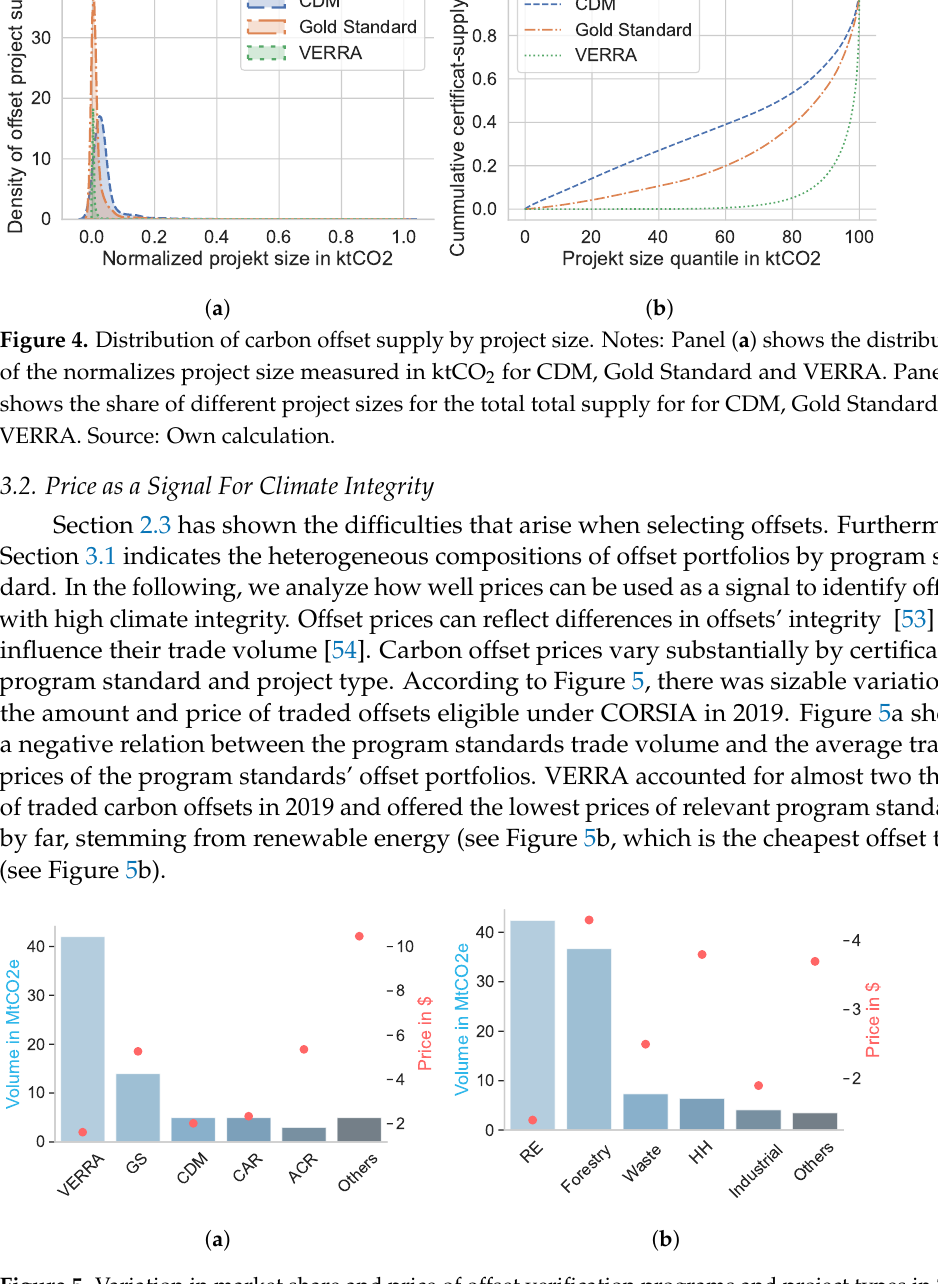
Figure 5. Variation in market share and price of offset verification programs and project types in 2019. Notes: Panel ( a ) shows 2019 traded offset volume in mtCO 2 e and price (in USD) per offset program, while Panel ( b ) shows the same for offset types. RE: Renewable Energy; HH: Household